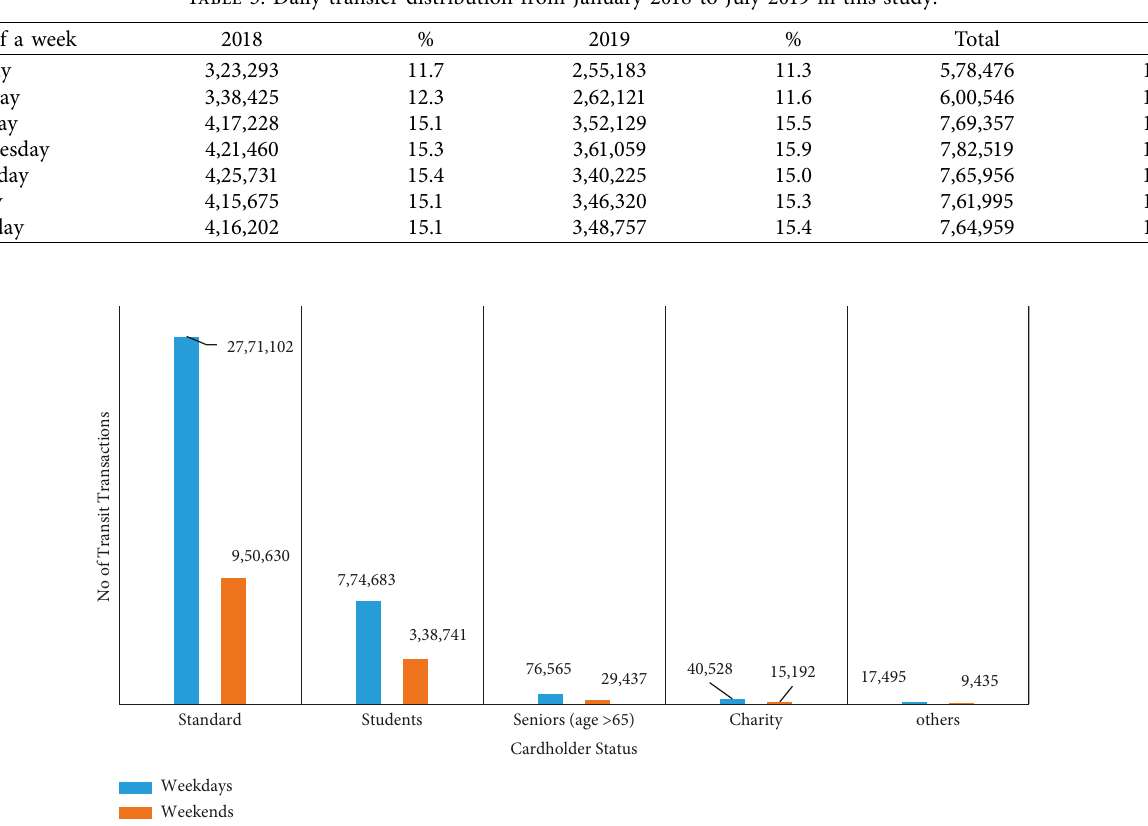
Figure 6: Transfer distribution of easy cardholders for weekdays and weekends from January 2018 to July 2019. Table 4: Examples of values of the RFM model via data transformation in the